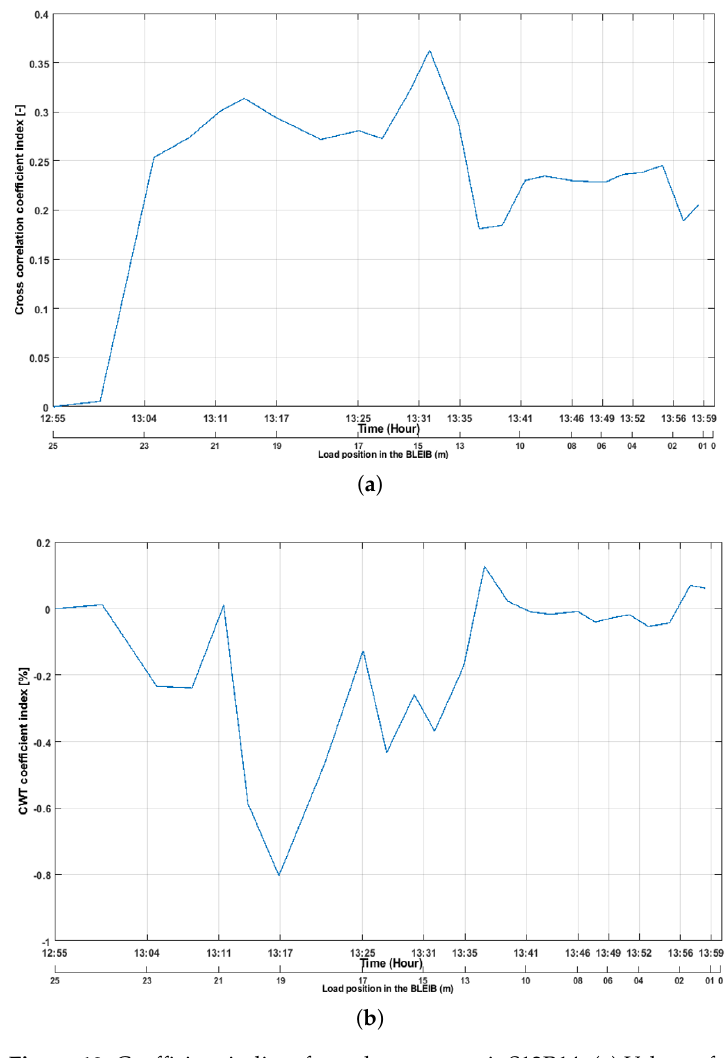
Figure 10. Coefficient indices from the sensor pair S12R14. ( a ) Values of cross-correlation coefficient ( Dcc ) index from the sensor pair S12R14; ( b ) Values of CWT coefficient index from the sensor pair S12R14.